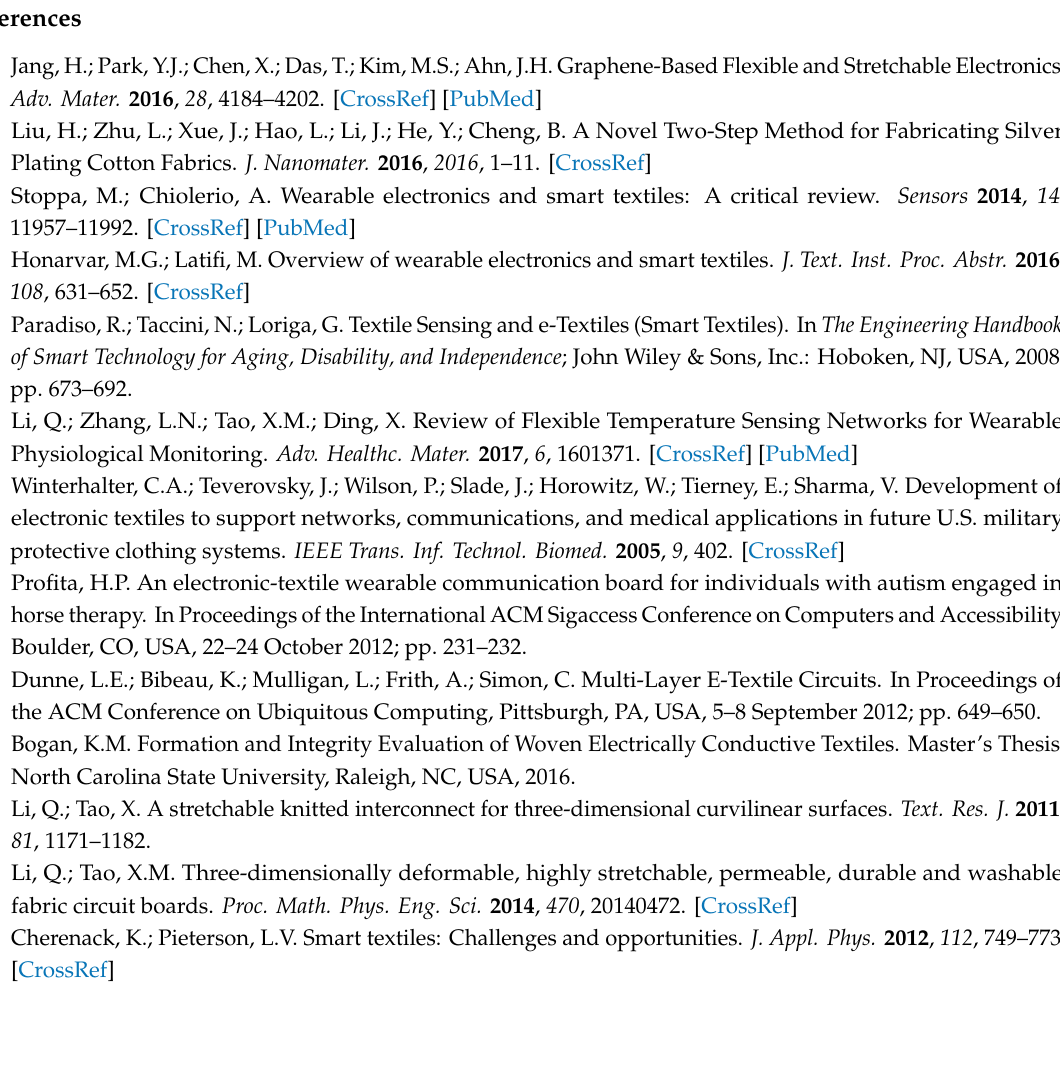
Figure S1: Relative resistance change with applied strain for di ff erent weaving structures of the FCB; Figure S2: Relative resistance change-strain relation of the SCPY; Figure S3: Resistance-strain relation of the other four specimens of the FCB; Figure S4: Fabrication procedure of the permanent connection between the conductive track and the sensor electrode; Figure S5: Resistance of the SCPY as a function of time under 60 ◦ C temperature and 90%